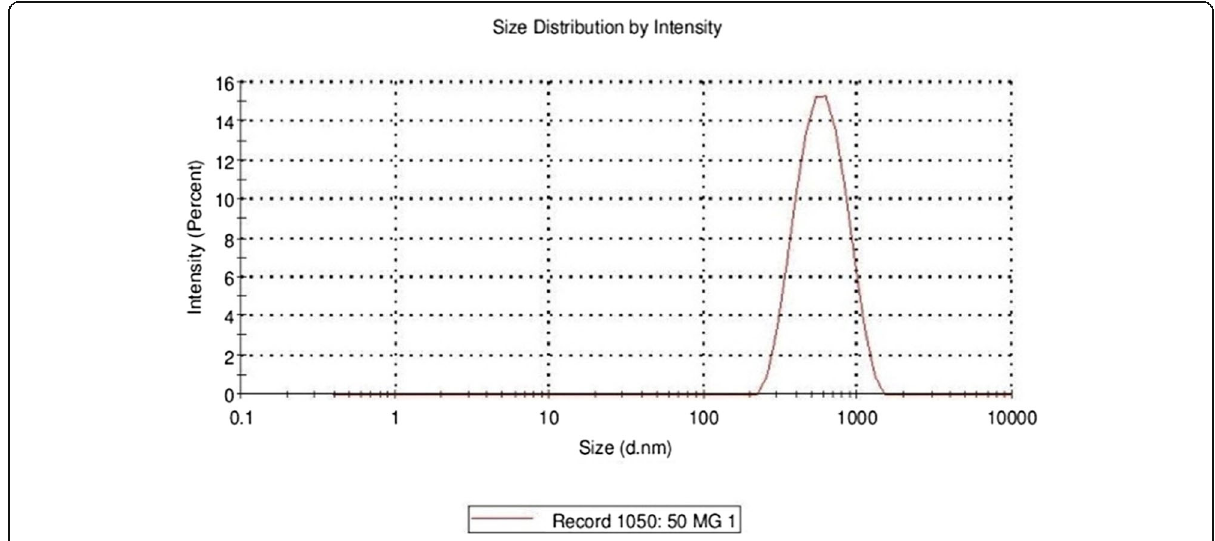
Fig. 2 Particle Size Distribution for Formulation EV 4